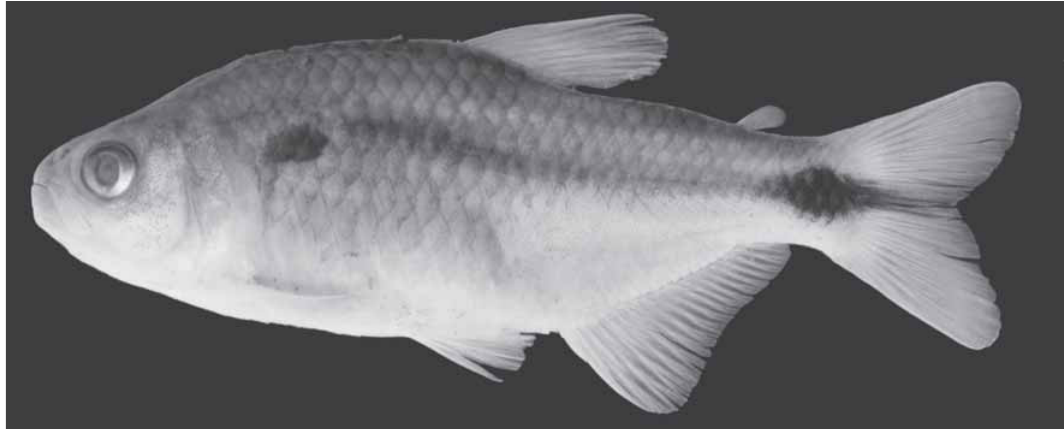
Fig. 1. Hyphessobrycon langeanii , holotype, MZUSP 75127, 50.4 mm SL, Brazil, Mato Grosso, município de Alto Araguaia, córrego Mosquito.